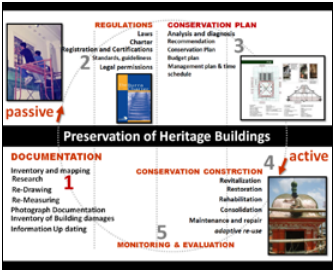
Figure 5. An endless process of documentation for each step of heritage building preservation shows its